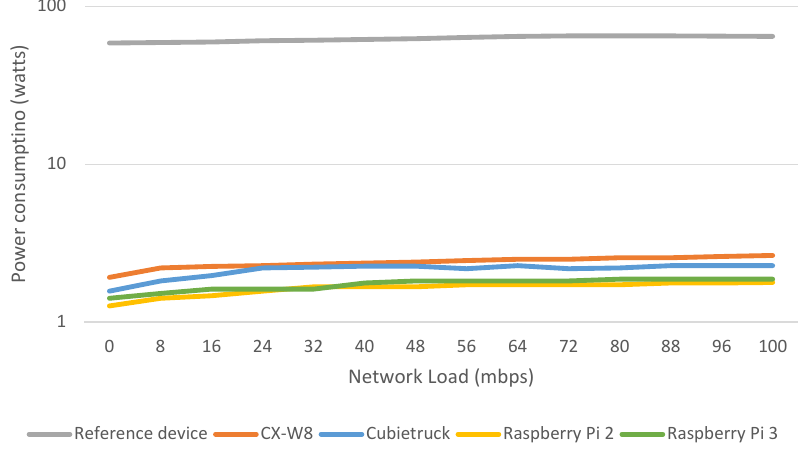
Figure 9. Result of the power consumption